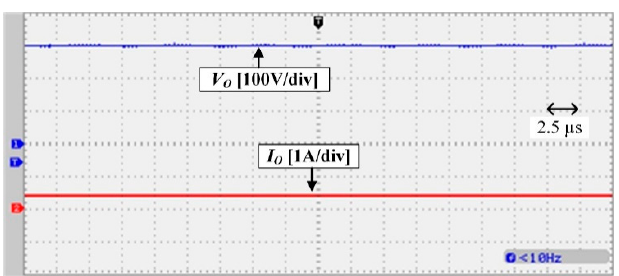
Figure 14. Voltage and current waveform of the diode D 4 .